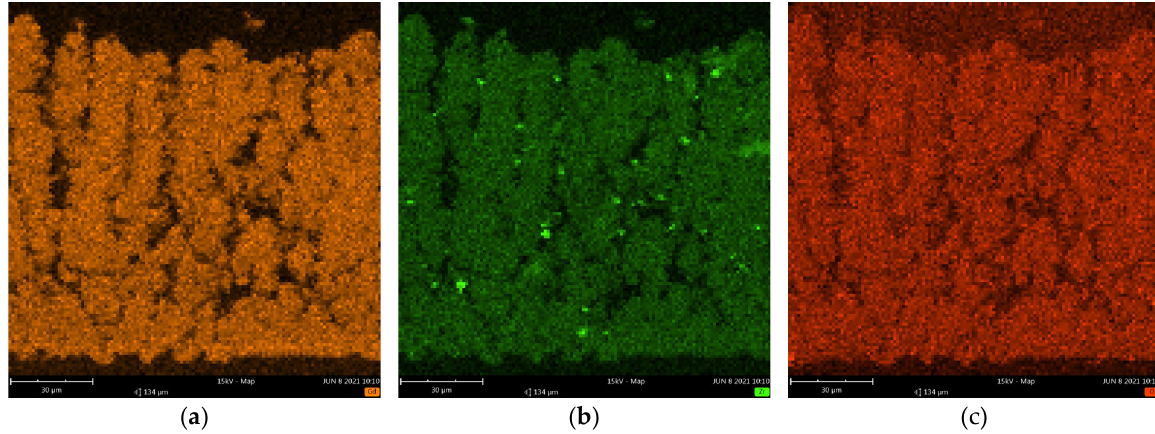
Figure 2. Elemental mapping of Gd ( a ), Zr ( b ) and O ( c ) distribution in GZO-2200 A coating synthetized in Reactive PS-PVD process using 2200 A power current.